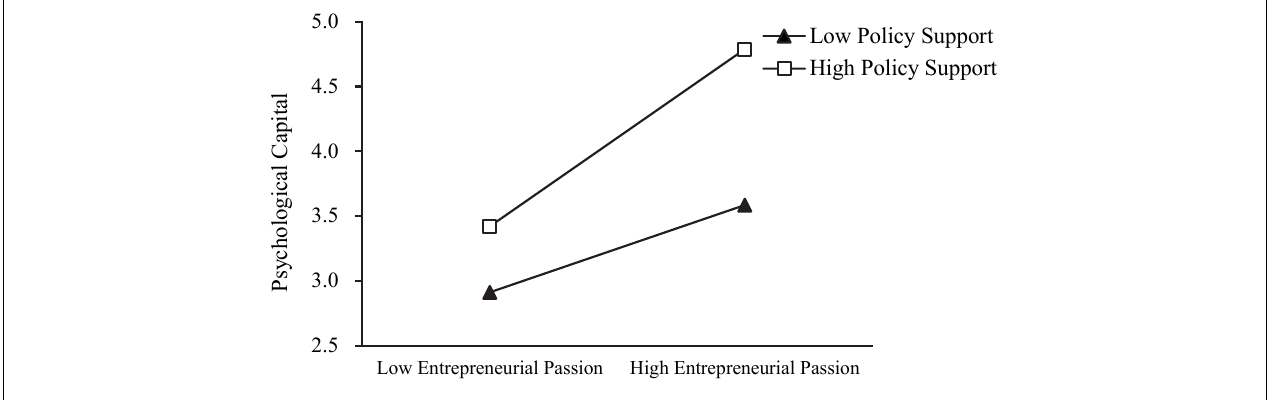
FIGURE 2 | Moderating effect of policy support between entrepreneurial passion and psychological capital.